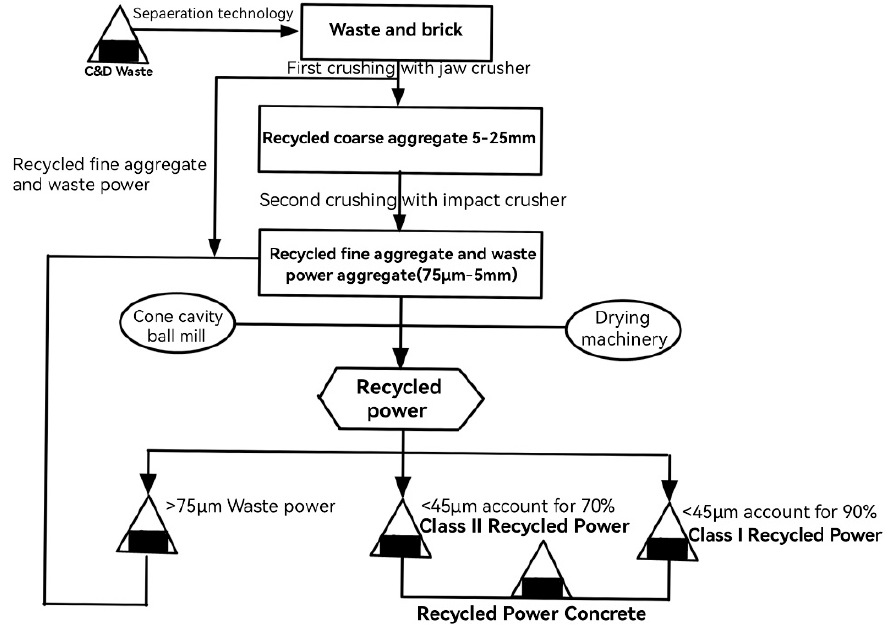
Figure 3. Preparation process of recycled powder.